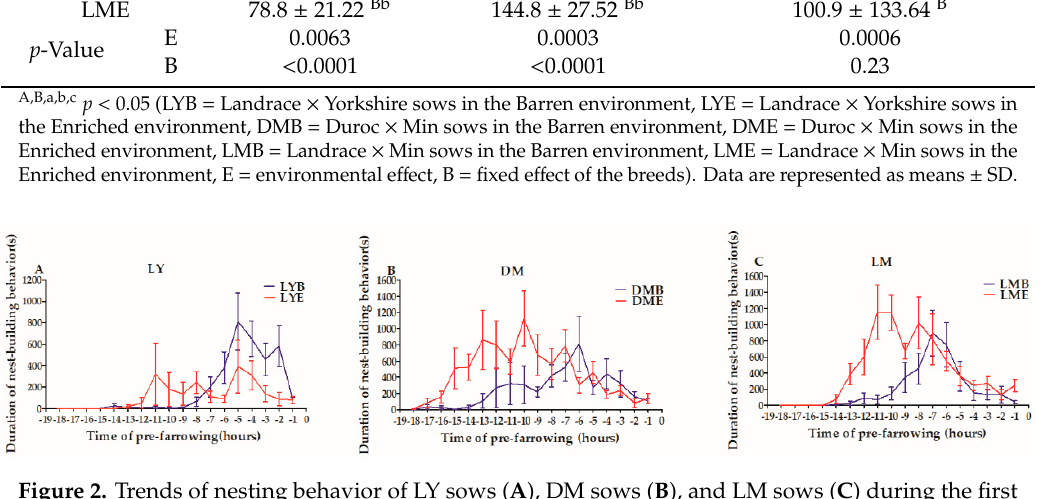
Figure 2. Trends of nesting behavior of LY sows ( A ), DM sows ( B ), and LM sows ( C ) during the first three days of litter bearing in EE and BE (LY = Landrace × Yorkshire sows, DM = Duroc × Min sows, LM = Landrace × Min sows, EE = Enriched environment, BE = Barren environment).